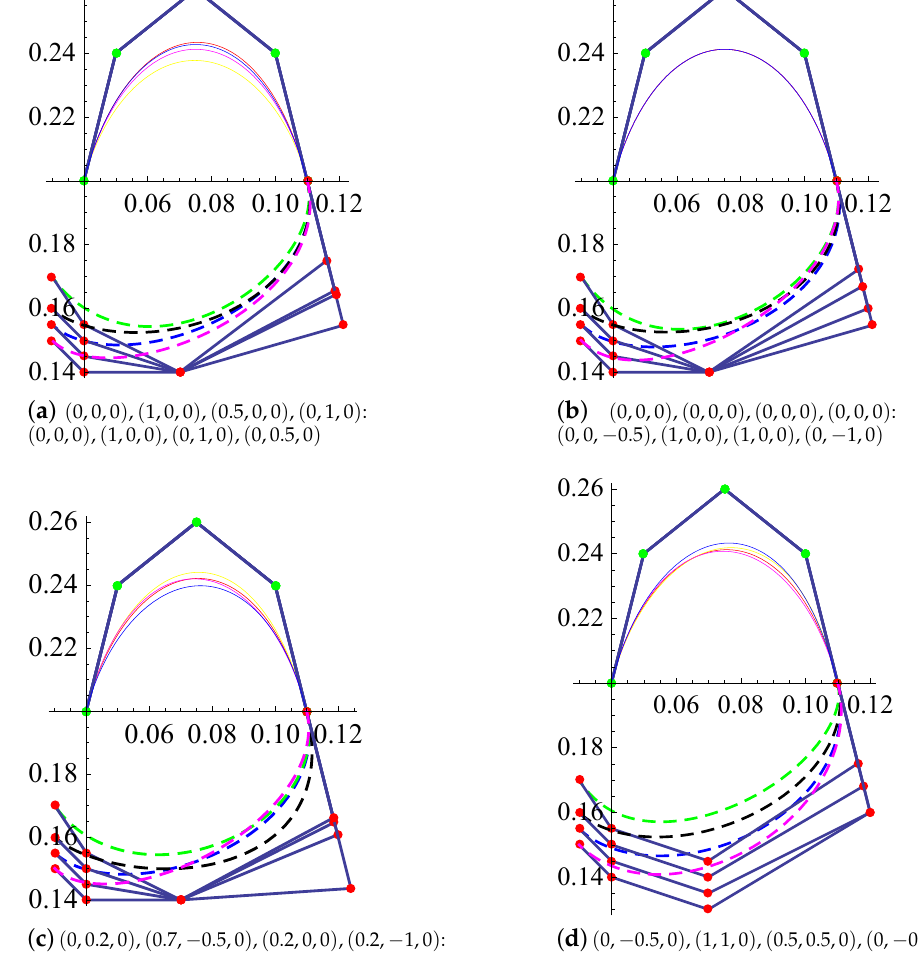
Figure 4. C 1 continuity of the GHT-Bézier curve by multi-valued shape parameters. ( a ) ( 0,0,0 ) , ( 1,0,0 ) , ( 0.5,0,0 ) , ( 0,1,0 ) : ( 0,0,0 ) , ( 1,0,0 ) , ( 0,1,0 ) , ( 0,0.5,0 ) ; ( b ) ( 0,0,0 ) , ( 0,0,0 ) , ( 0,0,0 ) , ( 0,0,0 ) : ( 0,0, 0.5 ) , ( 1,0,0 ) , ( 1,0,0 ) , ( 0, 1,0 ) ; ( c ) ( 0,0.2,0 ) , ( 0.7, − − ( 1,0.75,1 ) , ( 1, 0.2,1 ) , ( 1, 1,1 ) ; ( d ) ( 0, 0.5,0 ) , ( 1,1,0 ) , ( 0.5,0.5,0 ) , ( 0, − − − ( 0.5,0.5,0 ) , ( 0, 0.5,0 ) −